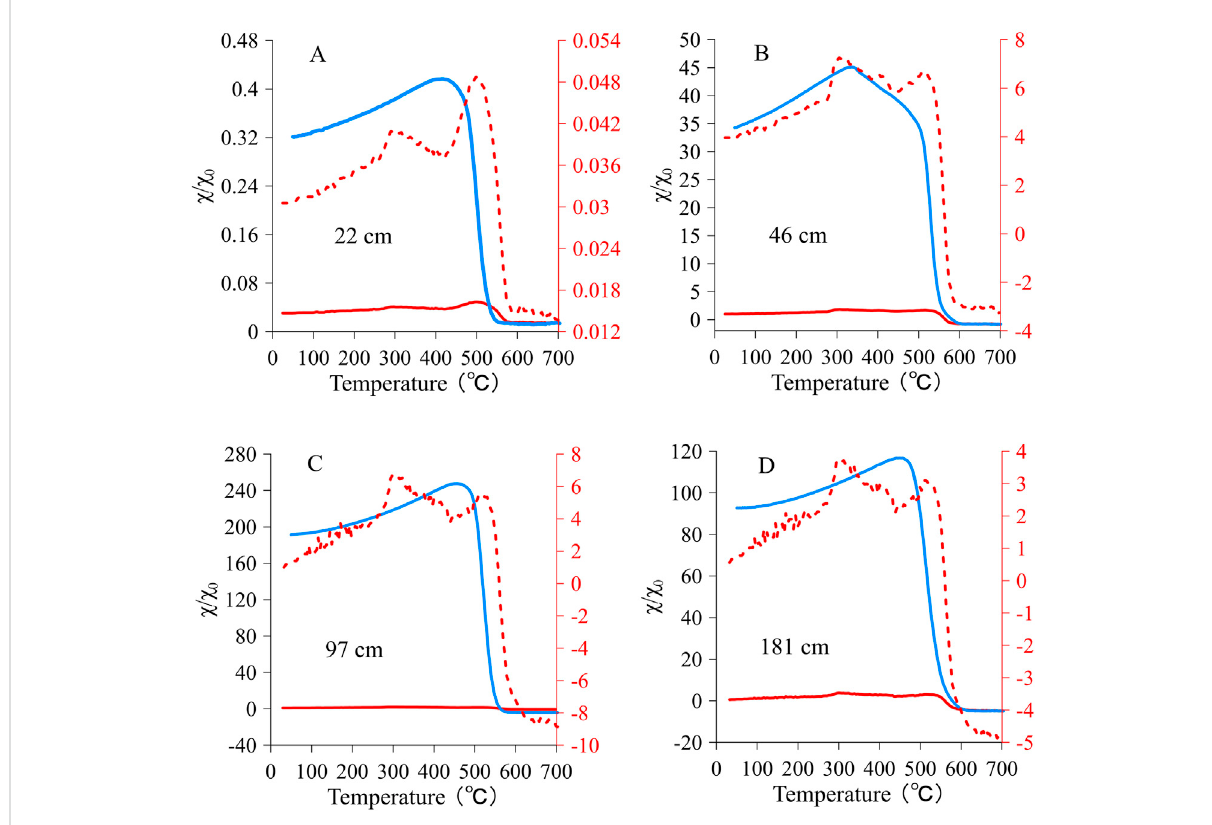
FIGURE 4 χ – TcurvesofrepresentativecoreH10samples.All χ valueswerenormalizedby χ valuesatroomtemperature.Redandbluelinescorrespondto the heating and cooling processes, respectively. (A – D) showed the results of representative samples at different